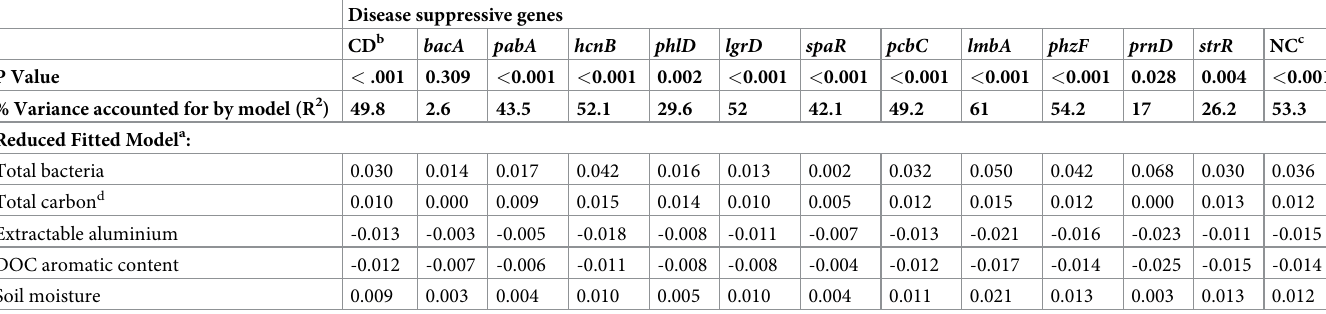
Table 4. The variation in disease suppressive gene abundance accounted for by a reduced linear